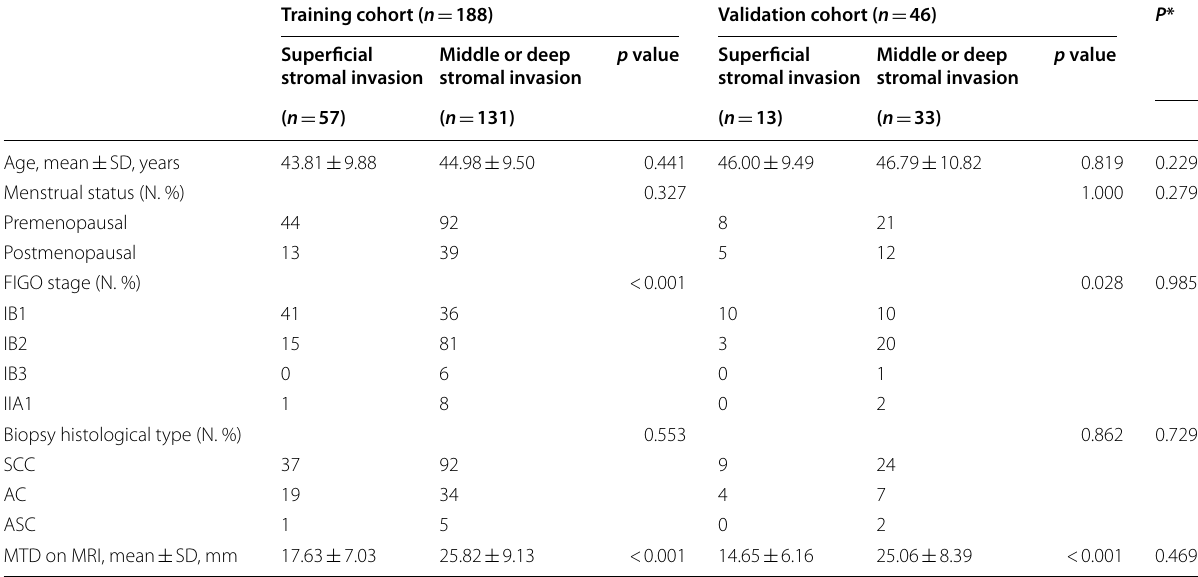
P is derived from the univariable association analysis of each clinical variable between superficial stromal invasion patients and middle or deep stromal invasion patients in the training and validation cohort, respectively. P * represents the difference of each clinical variable between the training and validation cohorts SD, standard deviation; FIGO, Federation International of Gynecology and Obstetrics; SCC, squamous cell carcinoma; AC, adenocarcinoma; ASC, adenosquamous carcinoma; MTD, maximal tumor diameter